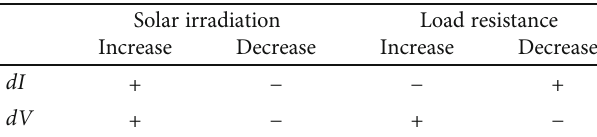
Table 2: Variation in the voltage and current during the variation in solar irradiation or load